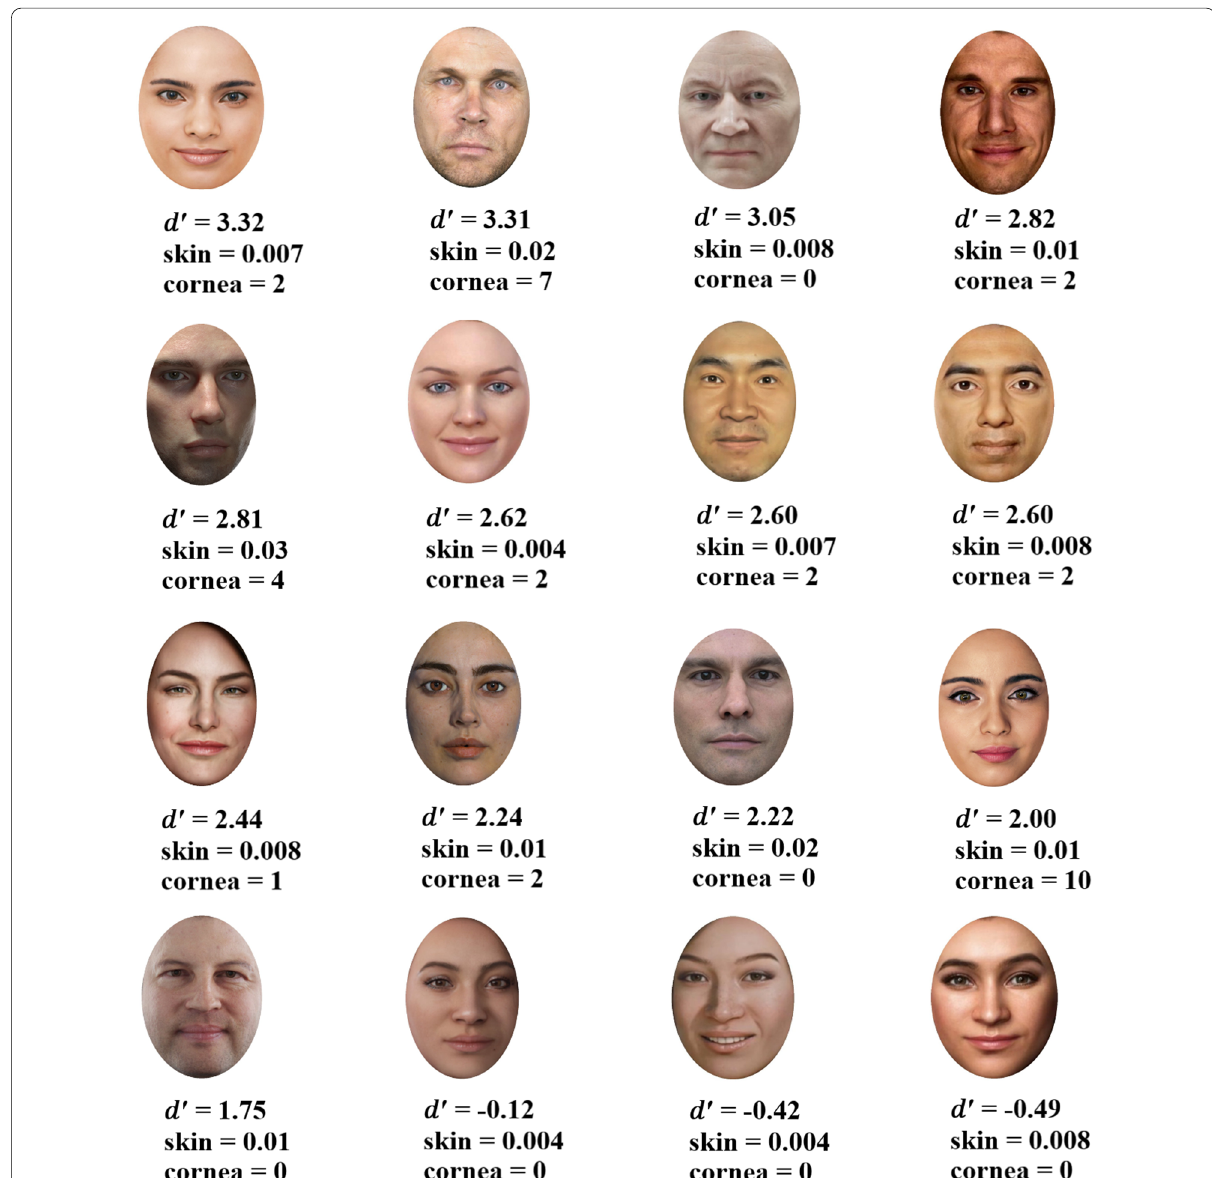
Fig. 2 d ′ scores averaged across participants (top row), the skin contrast value denoted as “skin” (middle row), and the number of corneal reflections denoted as “cornea” (bottom row) for each virtual face. The larger values of d ′ show good memory, whereas the negative values indicate that the face was poorly